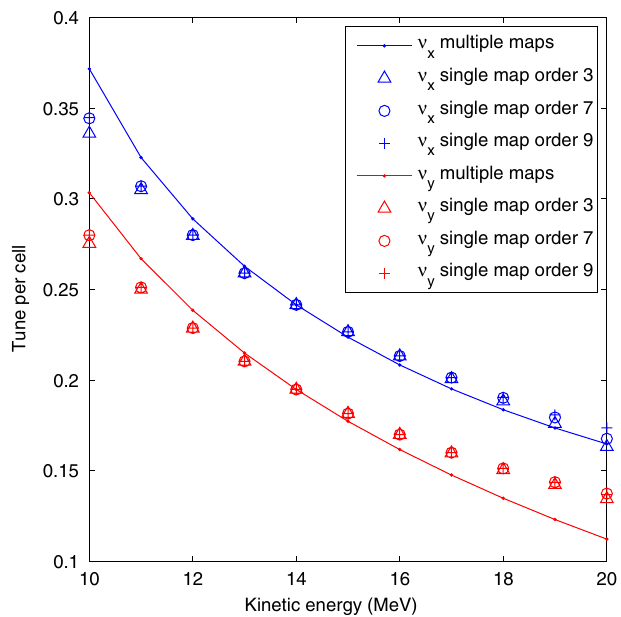
FIG. 7. Betatron tunes computed with a set of transfer maps at different reference energies (points on line), and with a single transfer map with different energy deviations (triangles, circles, crosses). The agreement between the two methods is better than the expected measurement precision of 0.01, for energy devia-